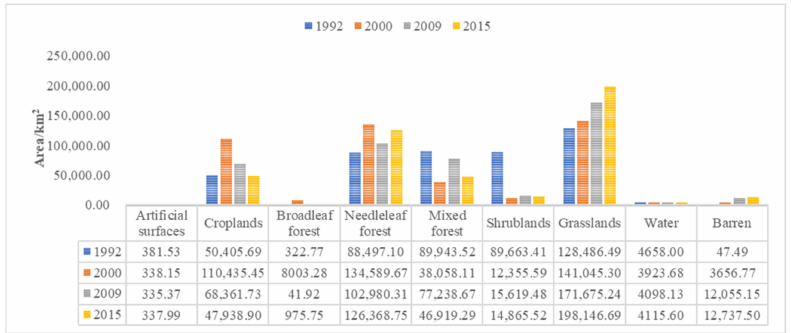
Figure 13. Classification and statistics of land use/cover patterns in the Selenga River basin.